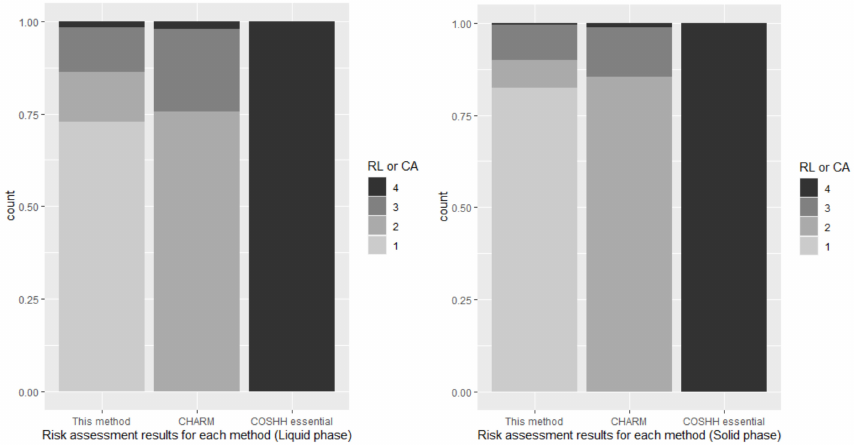
Figure 8. Risk assessment results for each phase and